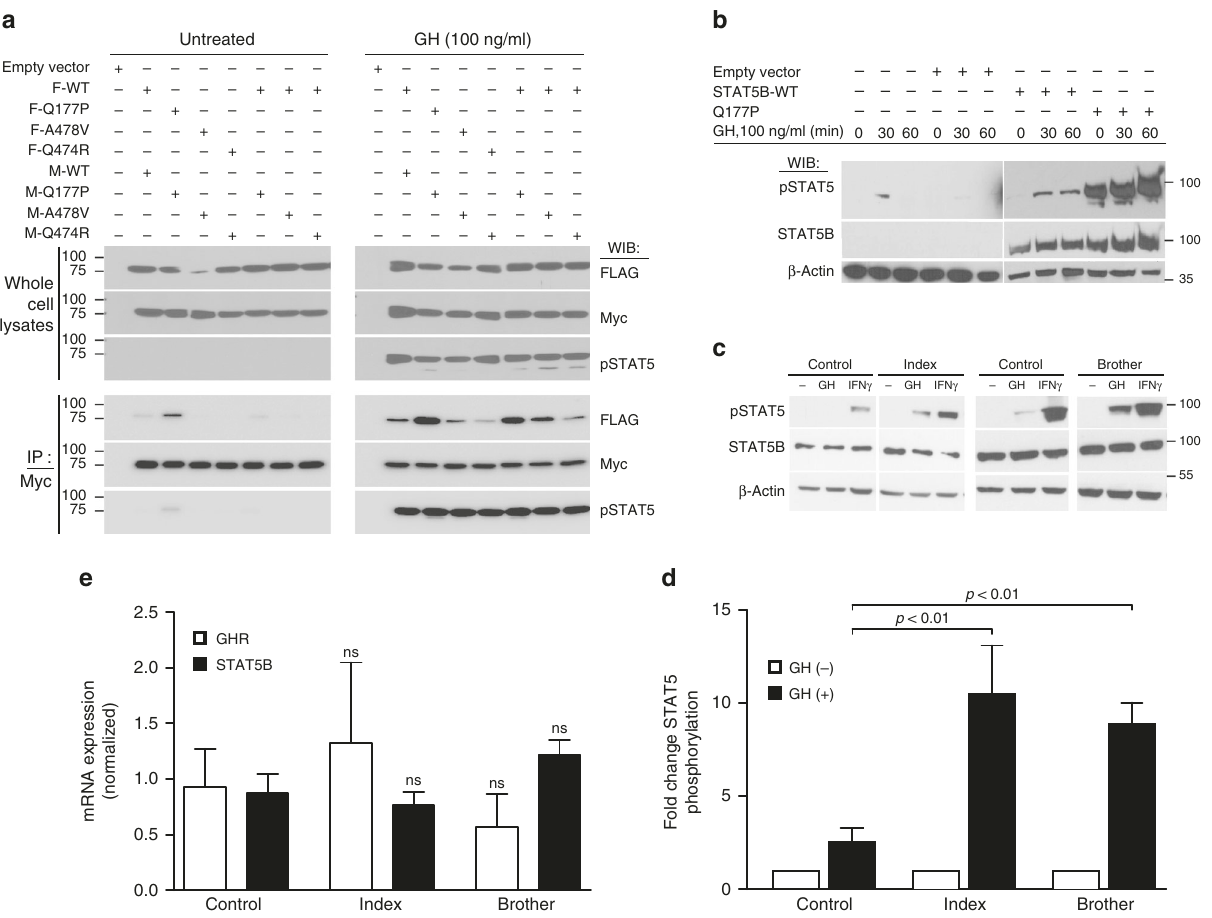
Fig. 2 GH-dependent STAT5B activation is retained by the missense variants. Whole-cell lysates from untreated or GH-stimulated (30 min or as shown) HEK293(hGHR) ( a ) or HEK293 ( b ) cells transfected with the indicated FLAG- (F) or Myc-tagged (M) STAT5B wild-type (WT) or variant plasmids (p. Gln177Pro, Q177P; p.Ala478Val, A478V; p.Gln474R, Q474R) were subjected to immunoprecipitation (IP) and/or immunoblotting (WIB) using antibodies as indicated (pSTAT5, phospho-Tyr-STAT5). Representative immunoblots of three experiments are shown. c – e Whole-cell lysates were prepared from primary dermal fi broblasts derived from affected twins in Family 1 and control fi broblasts, after stimulation with GH or IFN γ and immunoblotted for pSTAT5, total STAT5B, or β -actin as a loading control. Representative blot out of four independent experiments is shown. d Densitometric evaluation of pSTAT5 determined in patients ’ fi broblasts (fold change compared to untreated cells). pSTAT5 levels were normalized to total STAT5B and β -actin protein amounts in each sample. Data are shown as mean ± S.E.M. of three independent experiments. e qPCR veri fi cation of STAT5B and GHR mRNA